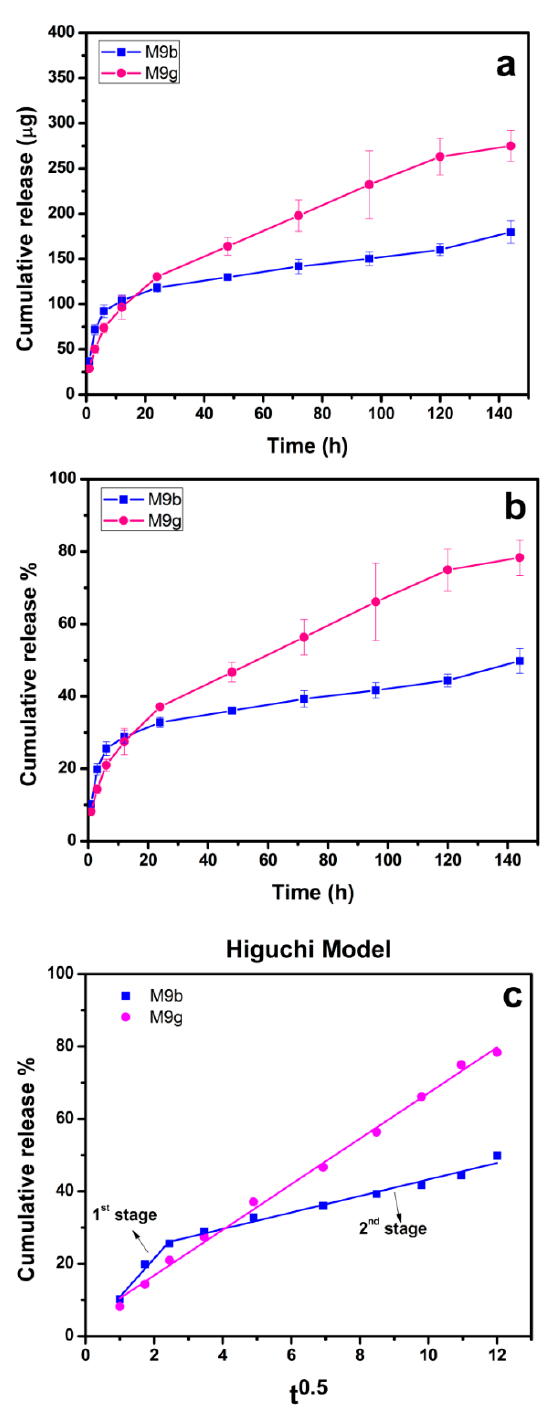
Figure 8. ( a ) Cumulative release amount ( µ g), ( b ) cumulative release %, and ( c ) fitting of release data with Higuchi model for M9b and M9g microspheres.